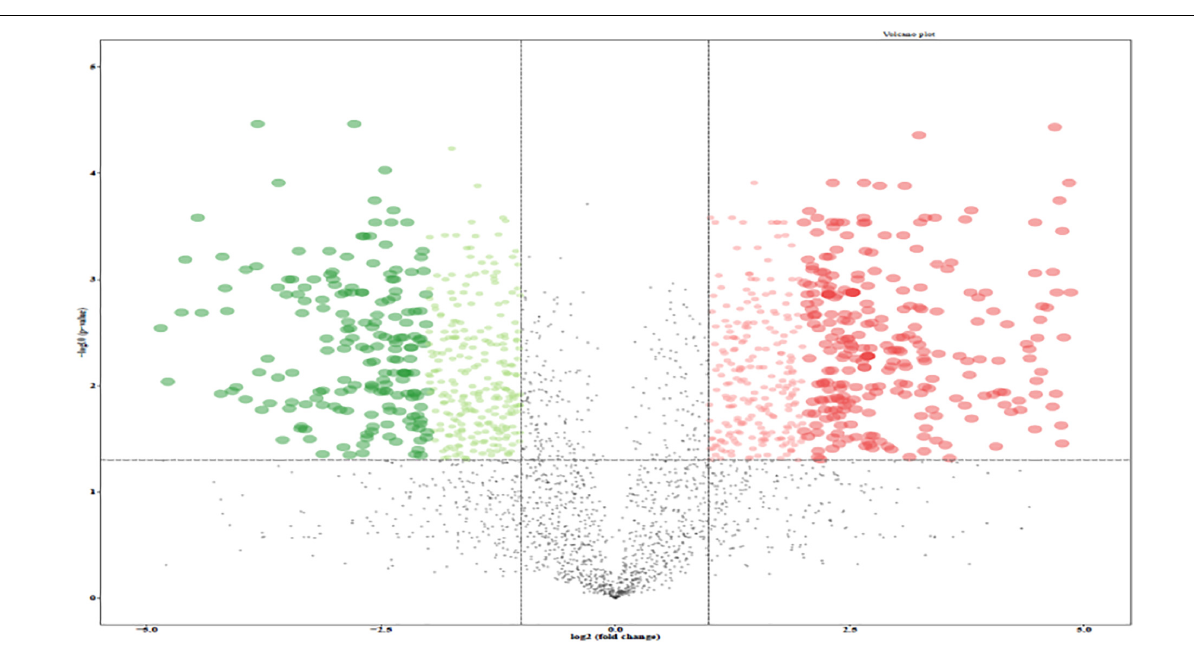
FIGURE 4 | Volcano plot of the differentially expressed genes (DEGs) between control group and 256 µ g/mL group. Red dots, green dots, and black dots represent genes with significantly up-regulated expression, significantly down-regulated expression and non-significant difference,